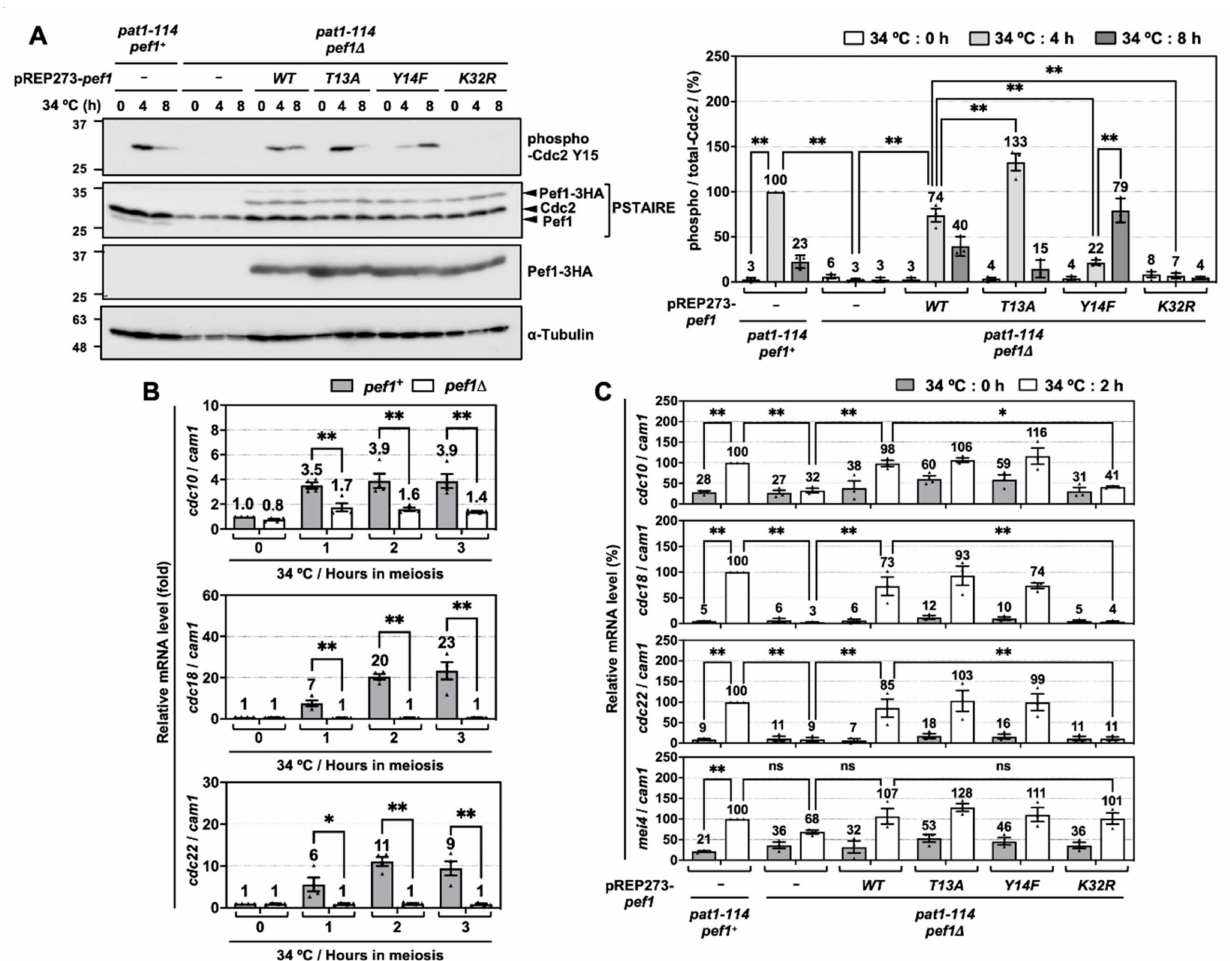
Figure 2. pef1 deletion suppresses the phosphorylation of Tyr-15 in Cdc2 and expression of DNA replication factors during early-phase meiosis. ( A ) pat1-114 pef1 + (FY7122) or pat1-114 pef1 ∆ (MS254) haploid cells transformed with pREP273-empty vector, pREP273- pef1 + , pREP273- pef1 T13A , pREP273- pef1 Y14F or pREP273- pef1 K32R were synchronized at the G1 phase by nitrogen starvation. Synchronous meiosis was induced by shifting the cultures from a permissive temperature (25 ◦ C) to a anti-phospho-Cdc2 Y15, anti-PSTAIRE and anti-HA antibodies. α -Tubulin was monitored as a loading control. The graph